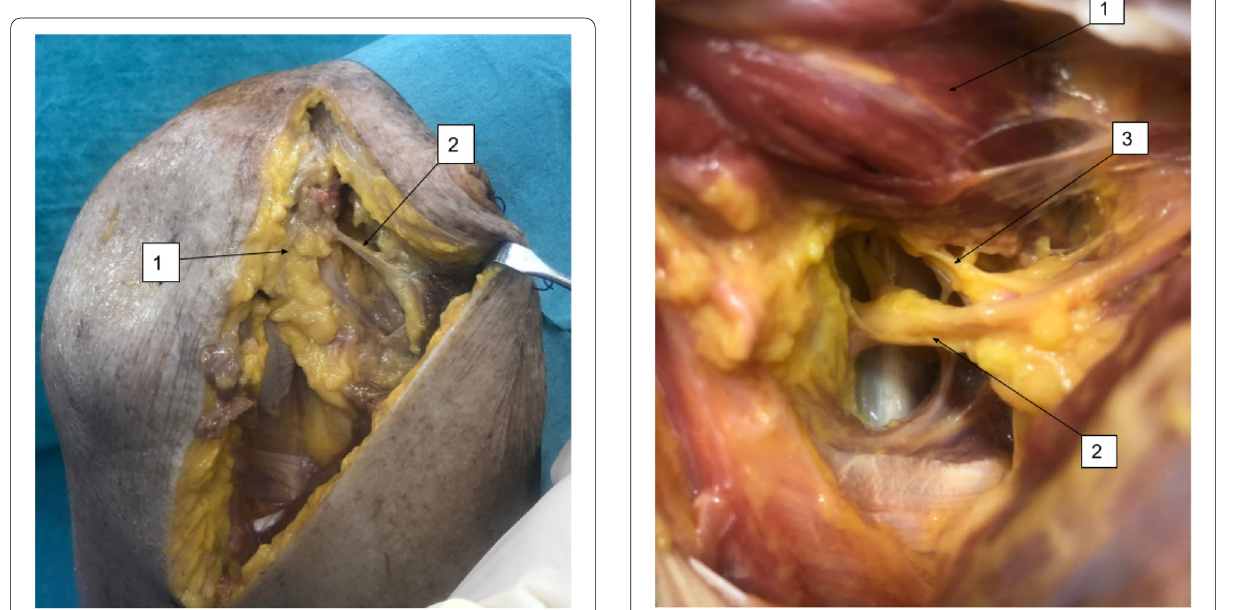
Fig. 1 Delto-pectroal approach. (1) Coracoid process; (2) Articular branch of the lateral pectoral nerve